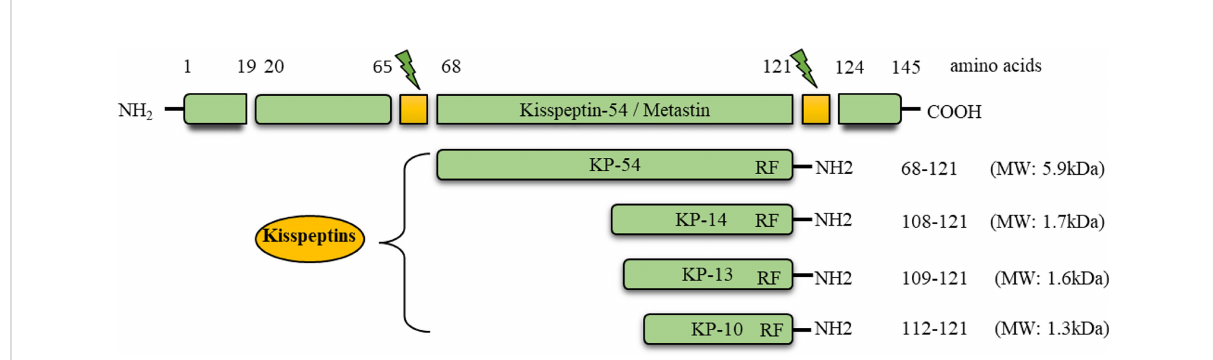
FIGURE 1 Conversion of prepro-kisspeptin into the active peptides. The prepro-kisspeptin is encoded by the KISS1 gene in primates and encodes a 145 amino acid prepro hormone (MW: ~15.4 kDa). This polypeptide is cleaved into 54, 14, 13, and 10 amino acids. The C-terminal, 10 amino acid sequence is conserved in all the forms, and can activate the G-protein coupled receptor, GPR54